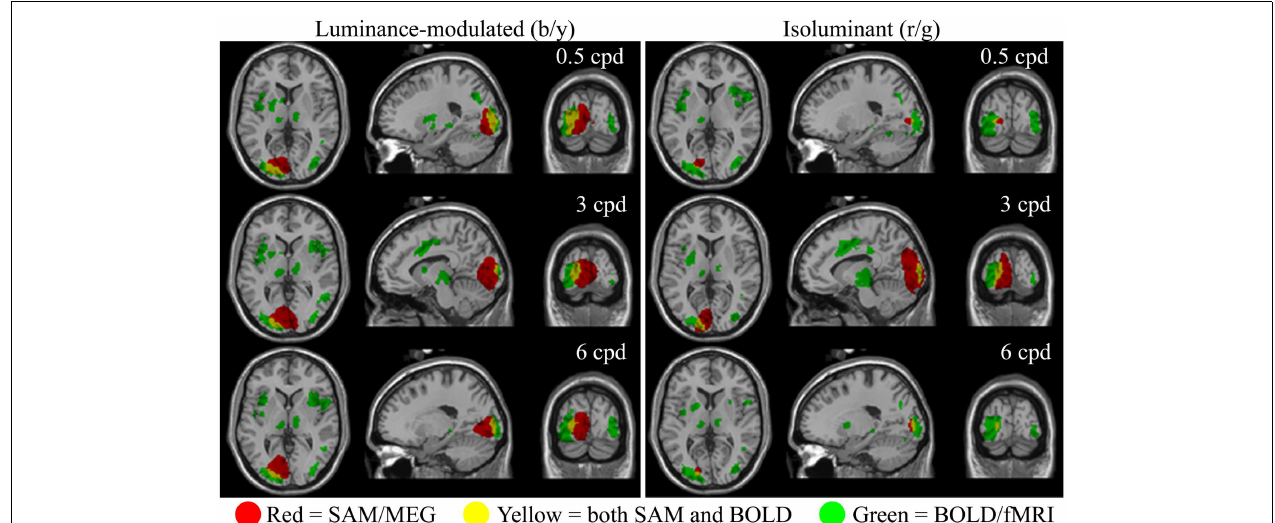
response.This was in the gamma band in all cases (Lum-mod: 0.5 cpd: 50–60Hz, t = 6.3, MNI: − 19.1, − 87.3, 3.0; 3 cpd: 50–60Hz, t = 7.1,